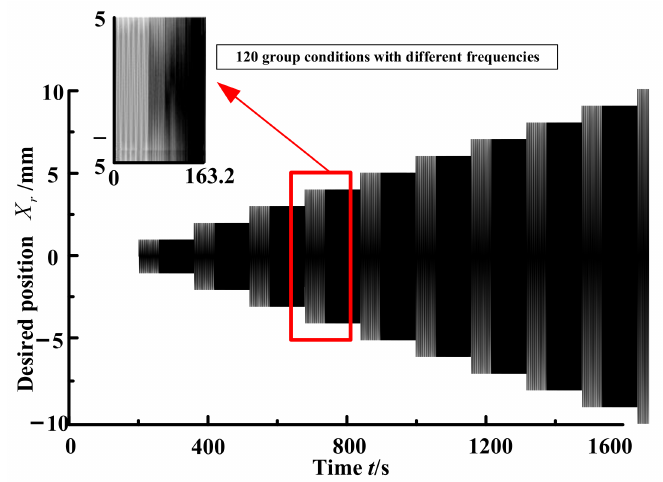
Figure 4. Desired position signals of input in the simulation. The P gain of controller in the simulation is shown in Figure 5.